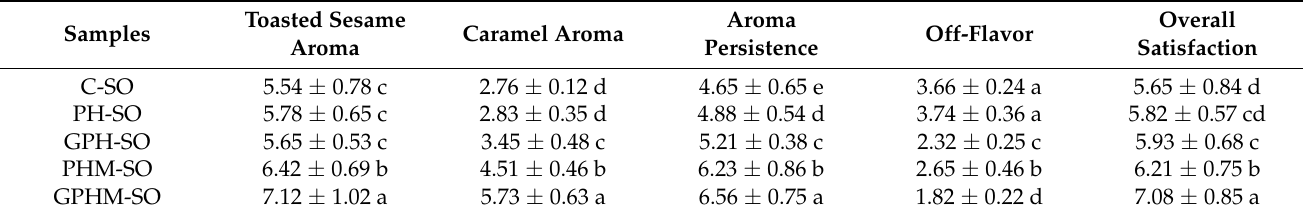
Table 3. The average scores of each sensory attribute in different